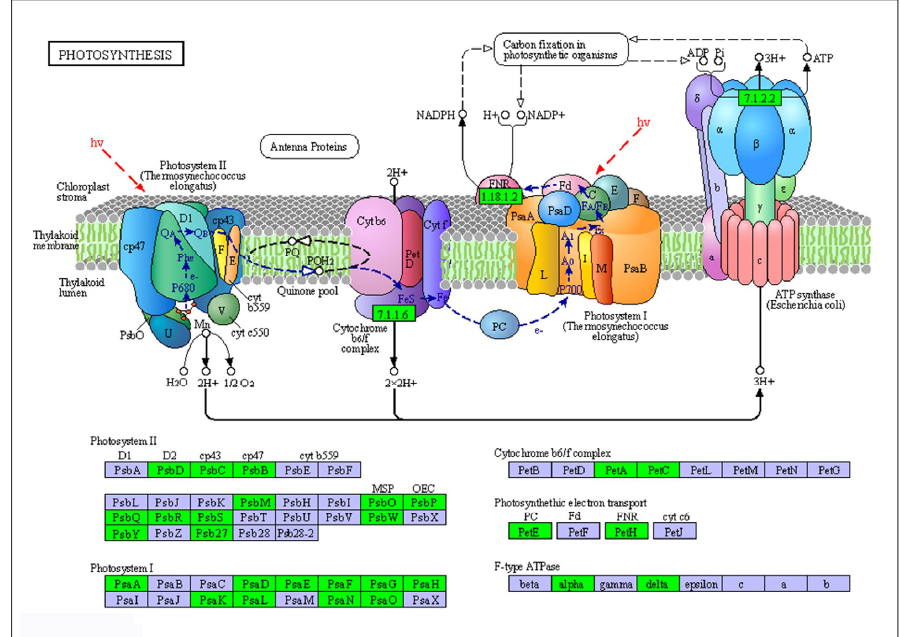
Figure 7. The photosynthesis pathways and the expression profile of DEGs in LC05 − 136. The green color represents the downregulated DEGs. color represents the downregulated